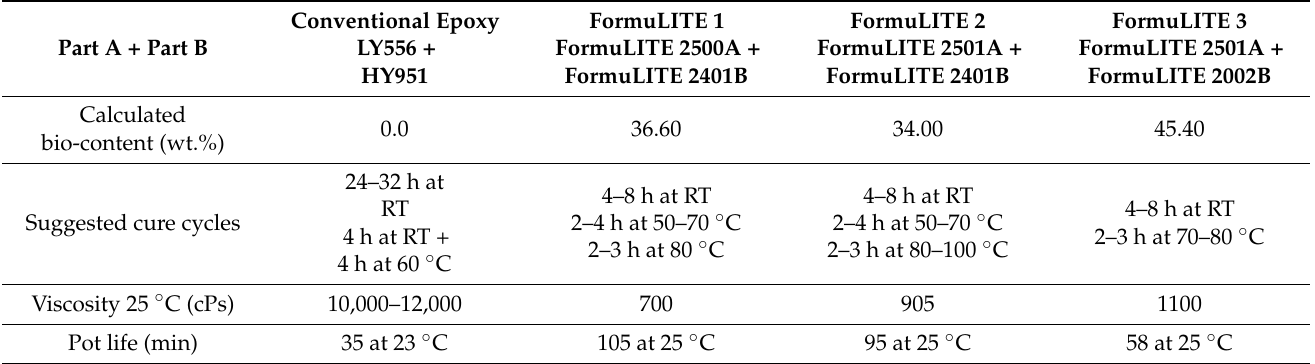
Table 1. Composition of conventional epoxy and FormuLITE amine-cured bio-based epoxy systems.